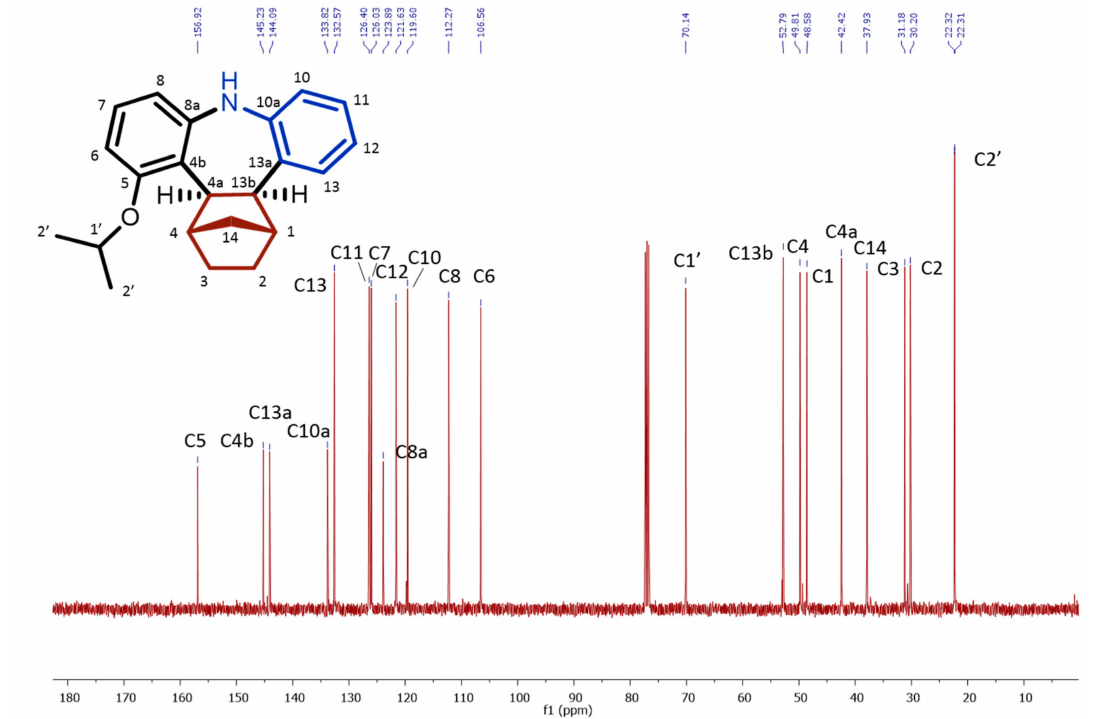
Figure 2. 13 C-NMR spectrum of compound 3 (CDCl 3 , 400 MHz) and related